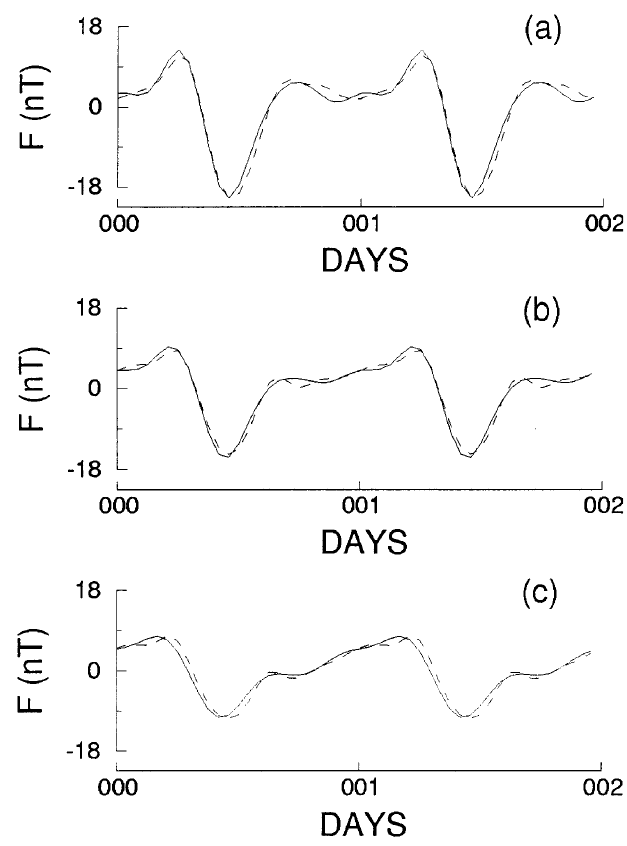
Fig. 5a–c. A comparison of the daily variations determined by HA ( solid curves ) and ANN ( dashed curves ) methods. The ANN was trained using the F -component data from three stations, namely HER, HBK, and TSU, for the years 1994 and 1995. The ANN was then used to estimate the daily variations for two-day intervals at a HER, c HBK, and b an intermediate latitude during mid-March